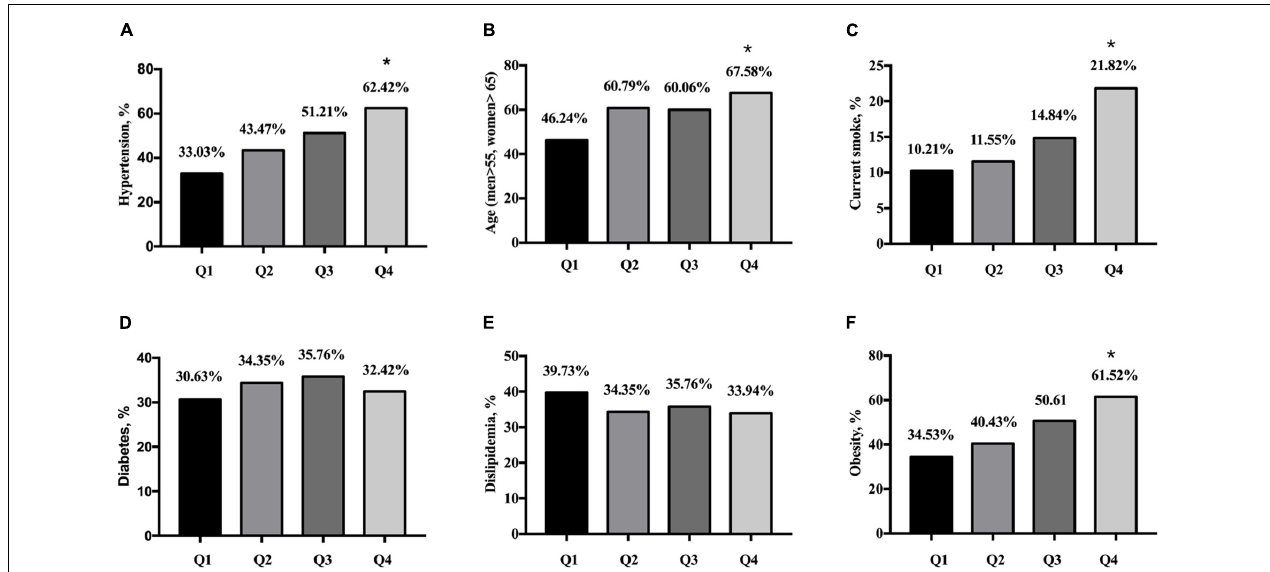
FIGURE 1 | Prevalence of cardiovascular disease risk factors according to quartiles of serum uric acid. (A) Prevalence of hypertension in quartiles of SUA. (B) Prevalence of age in quartiles of SUA. (C) Percentage of smoker in quartiles of SUA. (D) Prevalence of diabetes mellitus in quartiles of SUA. (E) Prevalence of dislipidemia in quartiles of SUA. (F) Prevalence of obesity in quartiles of SUA. Q1: SUA ≤ 4.78 mg/dL, n = 333; Q2: SUA 4.78–5.83 mg/dL, n = 329; Q3: SUA 5.83–6.86 mg/dL, n = 330; Q4: SUA ≥ 6.86 mg/dL, n = 330. SUA, serum uric acid. * p < 0.05 (the Q4 group vs. the Q1 group).